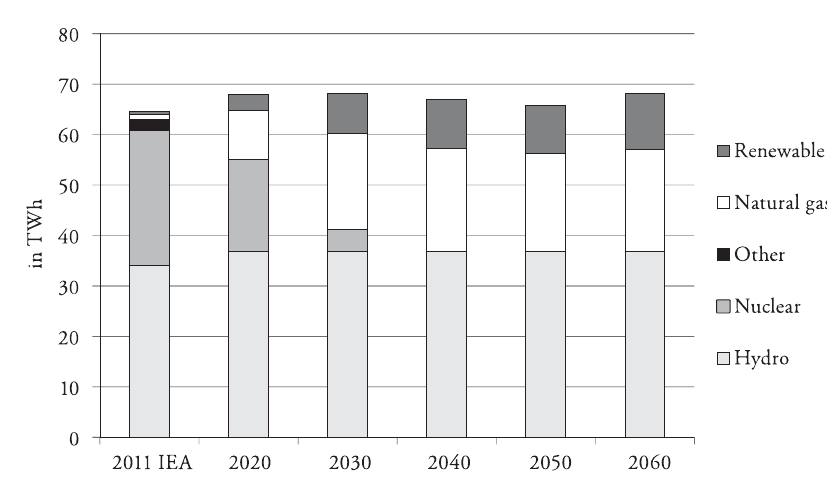
Figure 4: Electricity Generation in Switzerland in